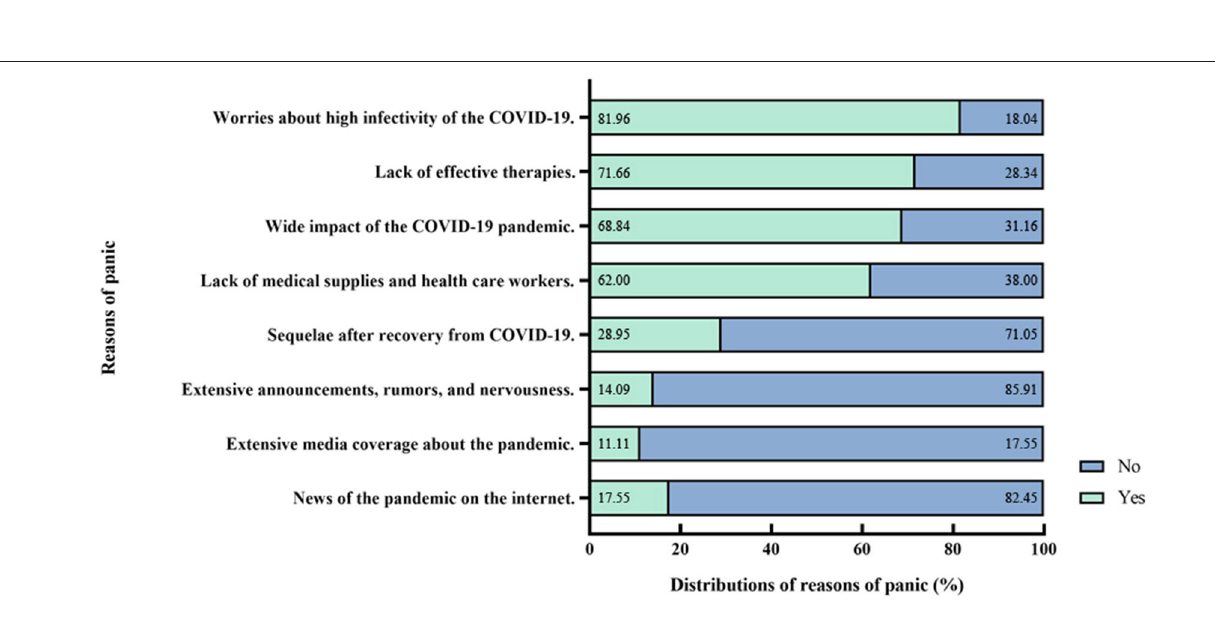
Frontiers in Medicine |